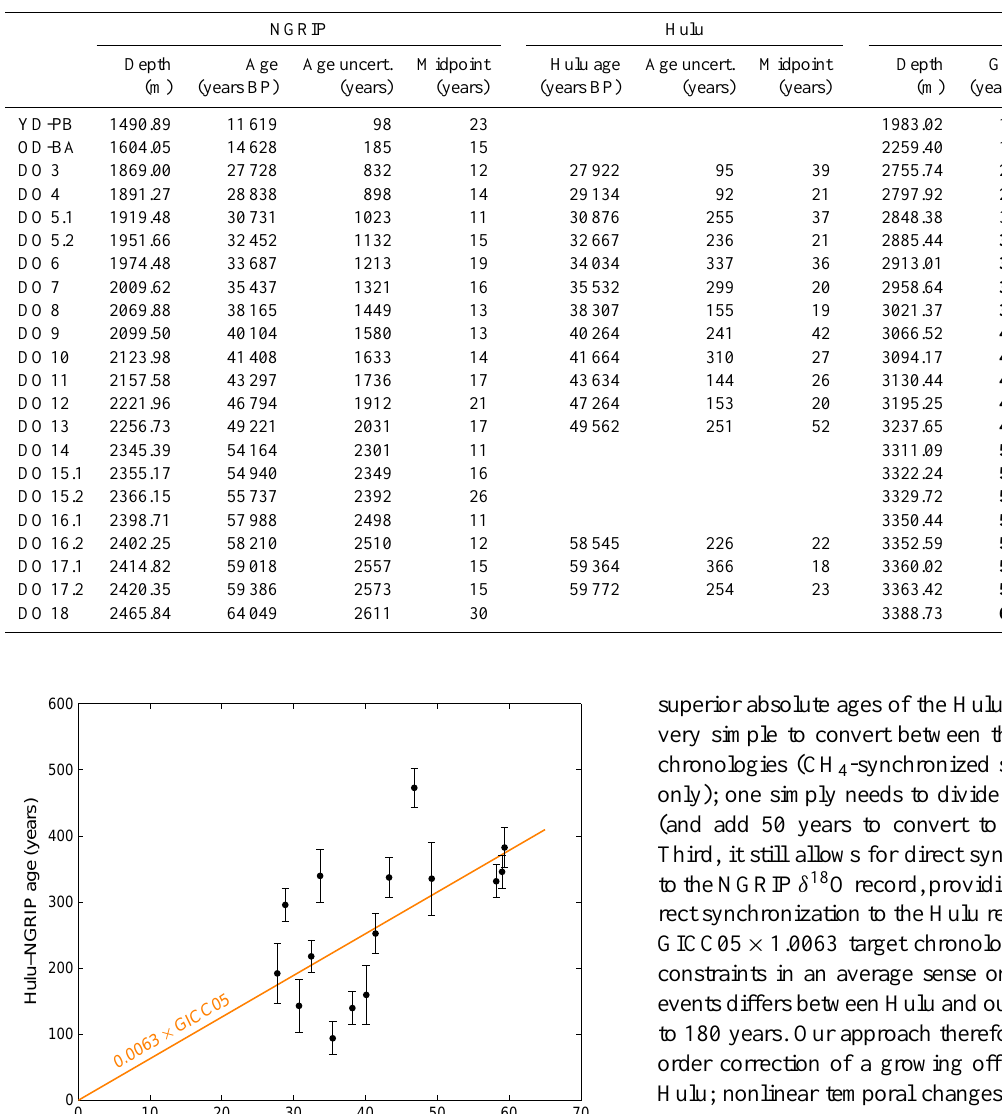
Table 1. Overview of CH 4 tie points for NH warming events. WD ages printed in boldface are assigned as part of the CH 4 synchronization; all other ages are on their independent chronologies.